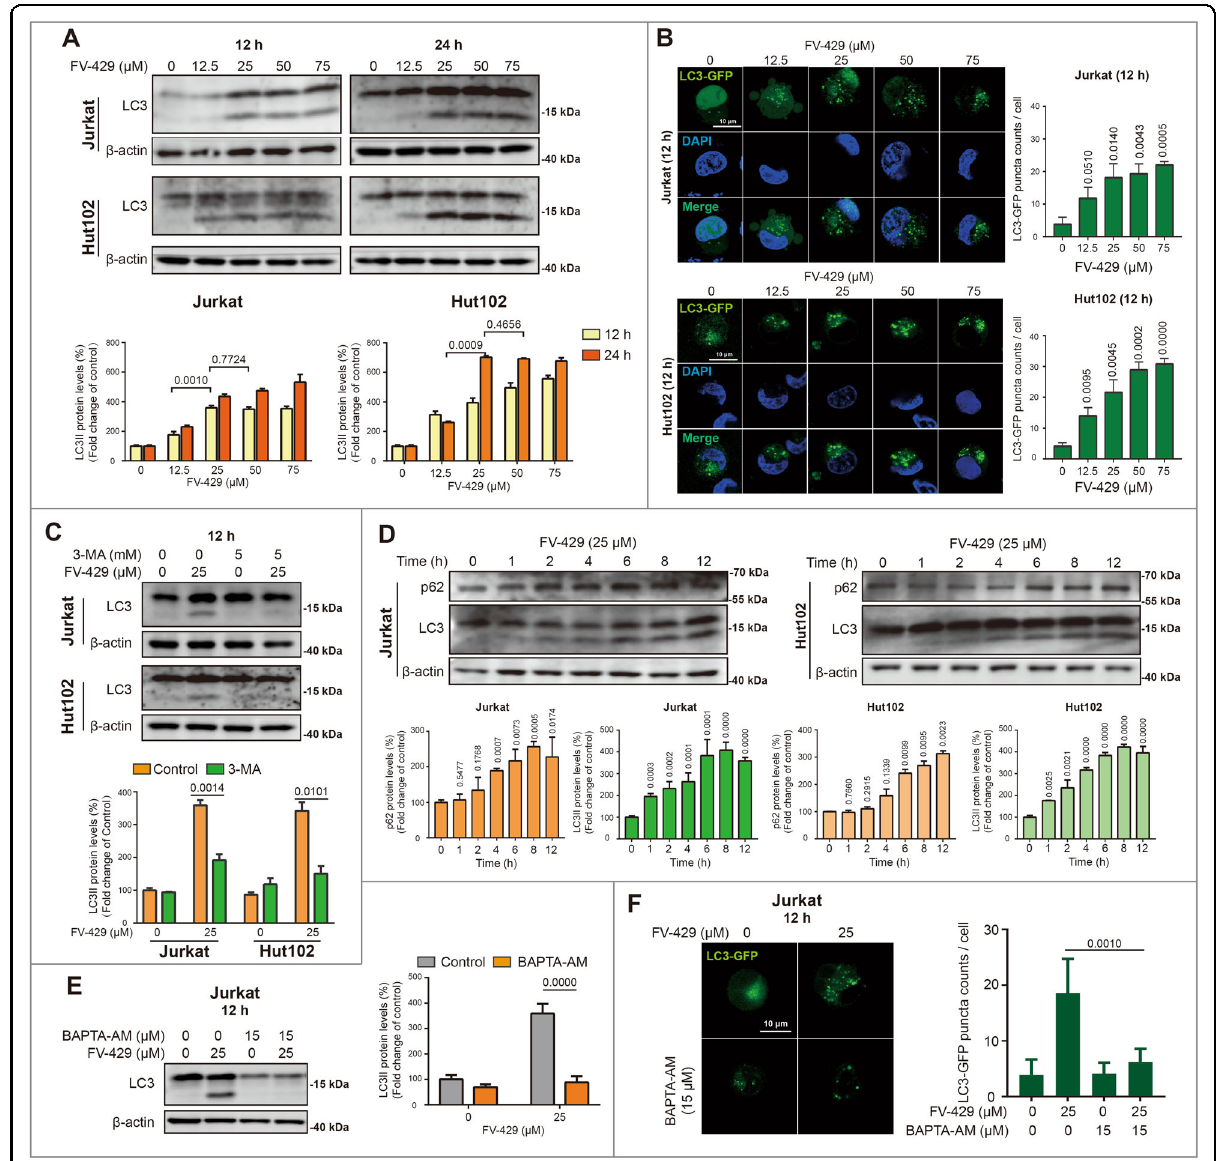
Fig. 1 FV-429 promotes LC3II accumulation. A The Jurkat and Hut102 cells were treated with 0, 12.5, 25, 50, and 75 μ M FV-429 for 12 and 24 h. The expression of LC3 was determined by western blot. B The Jurkat and Hut102 cells were transfected with a plasmid encoding LC3-GFP and treated with 0, 12.5, 25, 50, and 75 μ M for 12 h. The LC3II puncta determined by fl uorescence microscopy (scale bar: 10 μ m; the cells calculated in each group >50). C The Jurkat and Hut102 cells were treated with 25 μ M FV-429 and 3-MA (5 mM, pre-treated for 2 h) for 12 h. The protein expression of LC3 was determined by western blot. D The Jurkat and Hut102 cells were treated with 25 μ M FV-429 for 0, 1, 2, 4, 6, 8, and 12 h. The protein expression of LC3 and p62 was determined by western blot. E The Jurkat cells were treated with 25 μ M FV-429 and BAPTA-AM (15 μ M, pre-treated for 1 h) for 12 h, the protein expression of LC3 was determined by western blot. β -actin used as loading control in western blot. F The Jurkat cells were transfected with a plasmid encoding LC3-GFP and treated with 25 μ M FV-429 and BAPTA-AM (15 μ M, pre-treated for 1 h) for 12 h. The LC3II puncta determined by fl uorescence microscopy, and LC3II-GFP puncta count were calculated (scale bar: 10 μ m; total puncta in each group >200) (mean± s.e.m. for 3 independent experiments; p values are shown on the